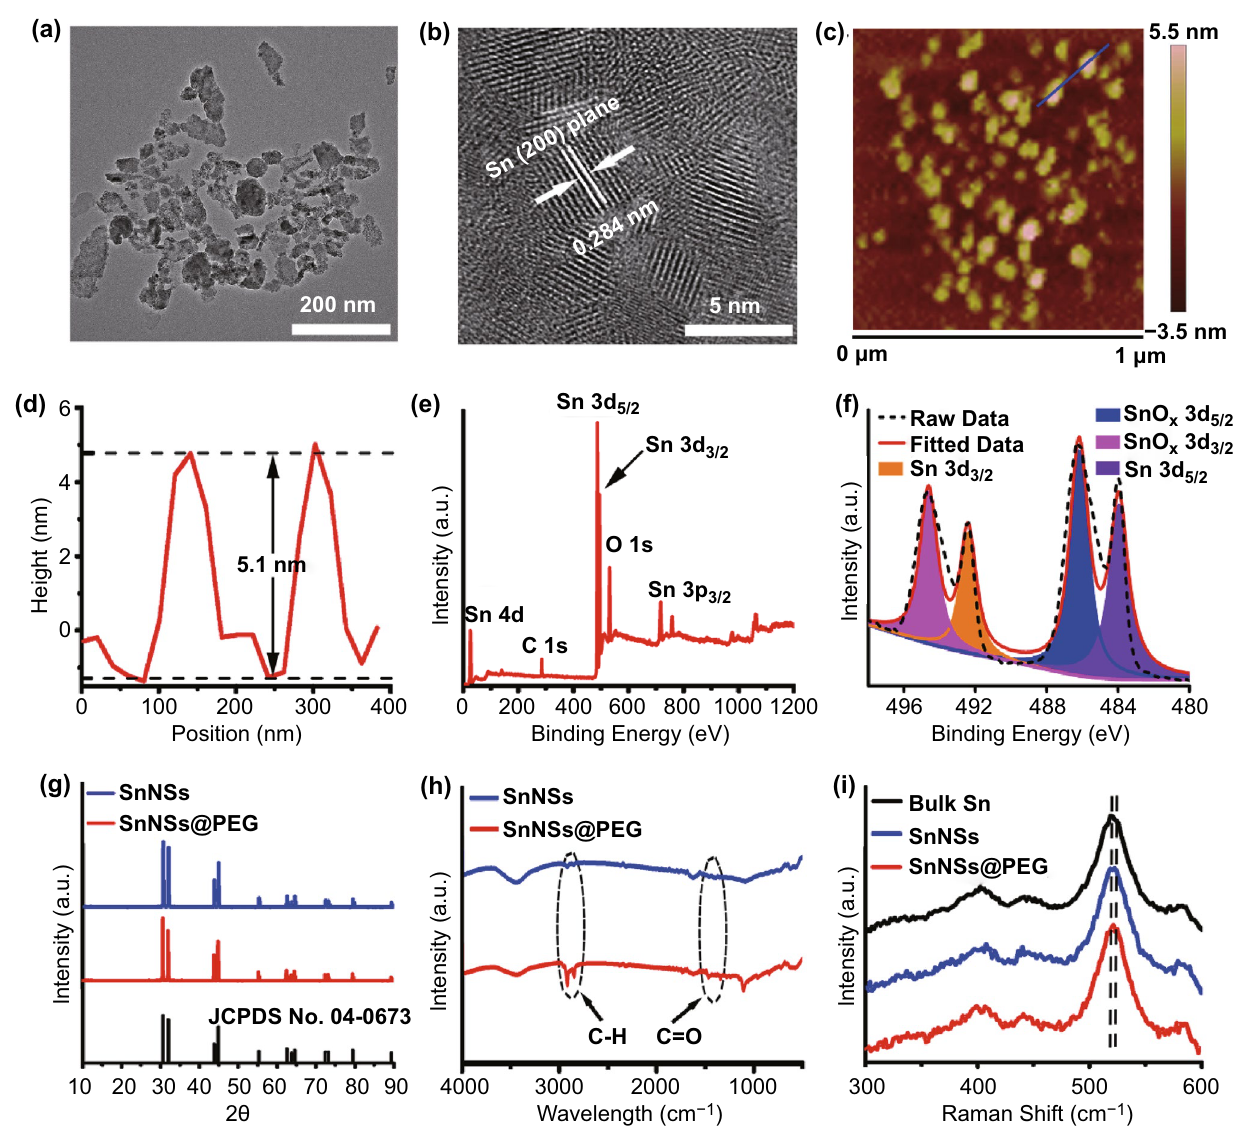
Fig. 1 a TEM image of SnNSs. b HRTEM image of SnNSs. c AFM image of SnNSs. d Thickness profile of SnNSs in c . e XPS survey spec‑ trum of SnNSs. f XPS spectrum of Sn 3d. g XRD profiles of SnNSs and SnNSs@PEG. h FTIR spectra of SnNSs and SnNSs@PEG. i Raman spectra of Bulk Sn, SnNSs, and